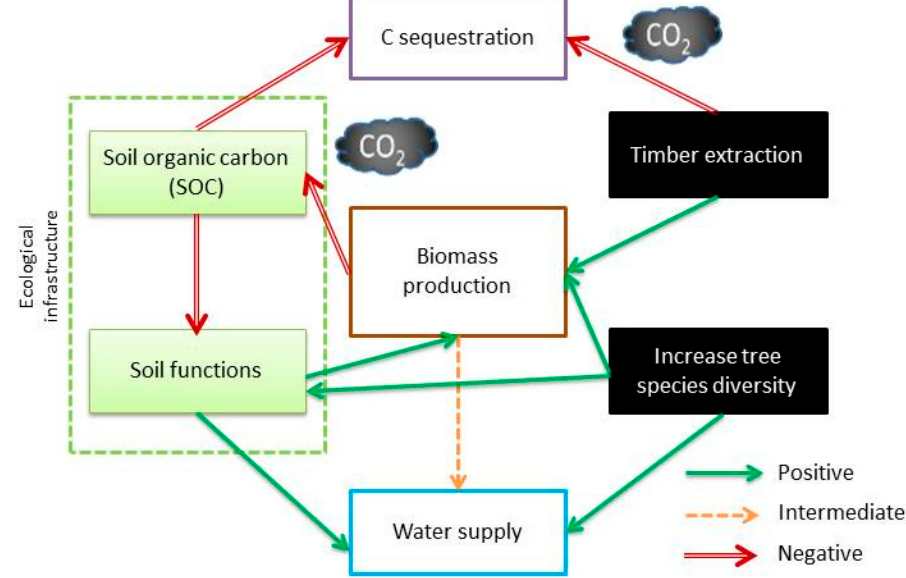
Figure 8. Relationship between ecosystem services, soil organic carbon, and soil functions in a scenario consisting of extracting timber and replacing with trees of different species (i.e., increase tree species diversity). Note that the maximum water supply would be achieved with an intermediate tree density [63].